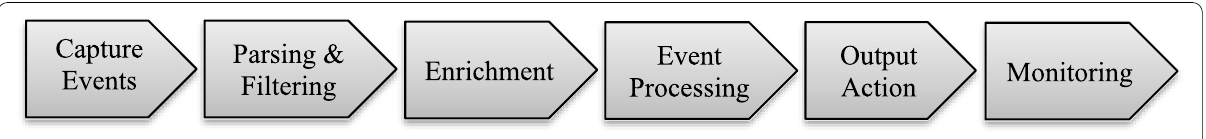
Fig. 5 Event processing